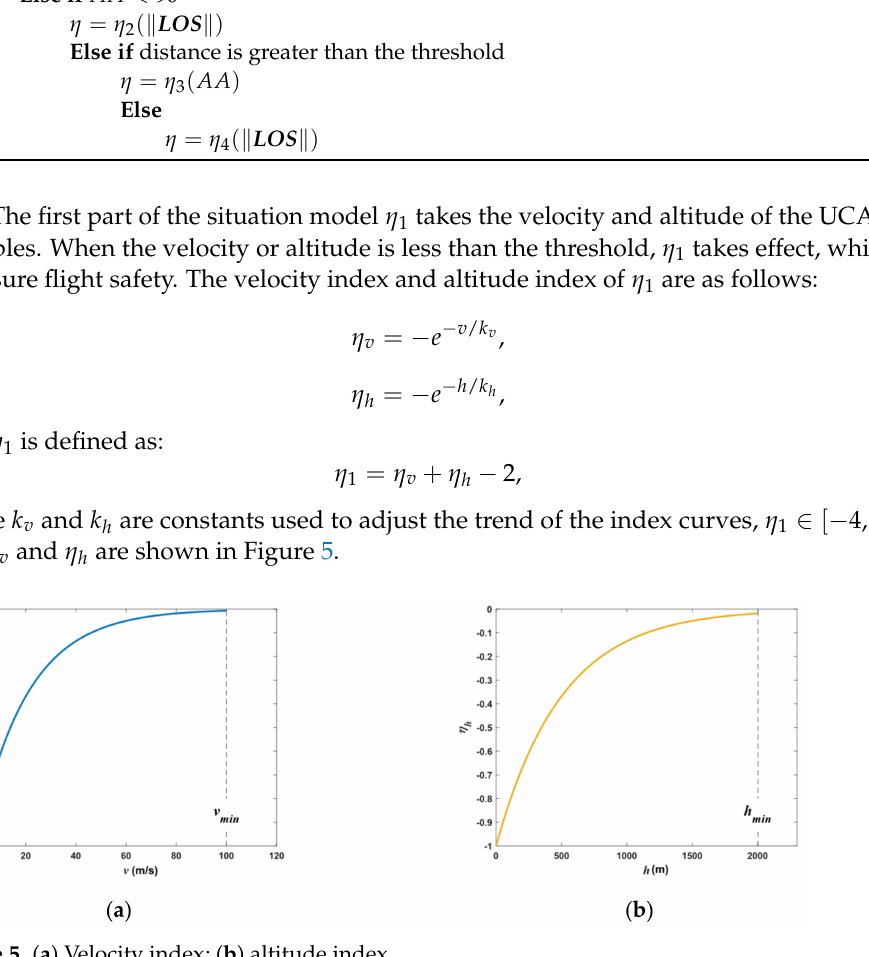
Figure 5. ( a ) Velocity index; ( b ) altitude